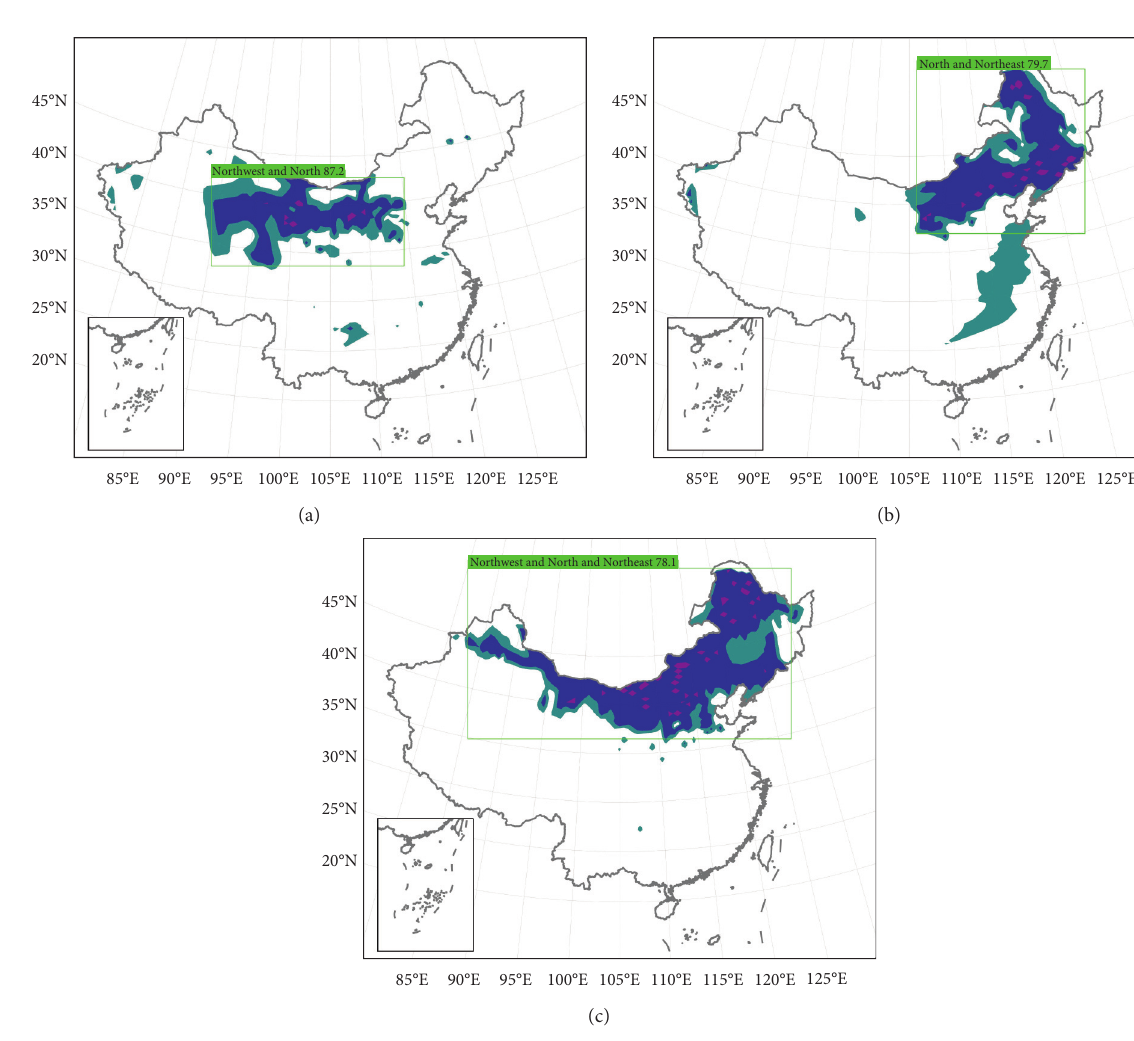
Figure 6: The effect of different single NITR paths. (a) is the NW+N path, (b) is the NE +N path, and (c) is the NW +N +NE